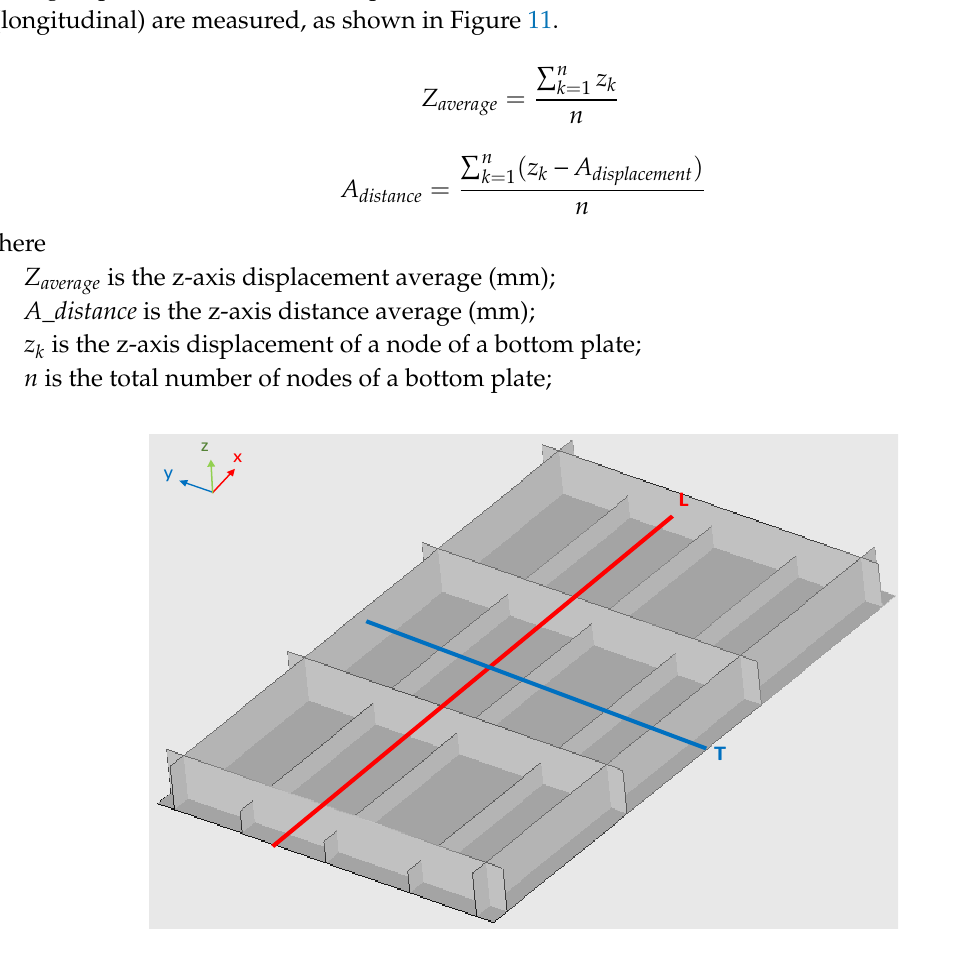
Figure 11. Measuring lines for the z-axis displacement distribution.